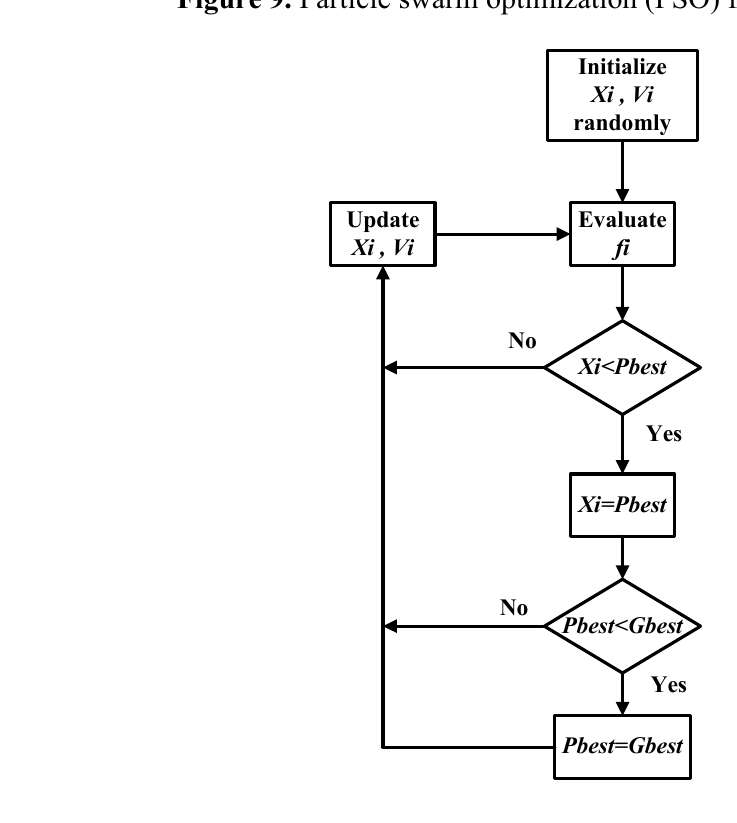
Figure 9. Particle swarm optimization (PSO)